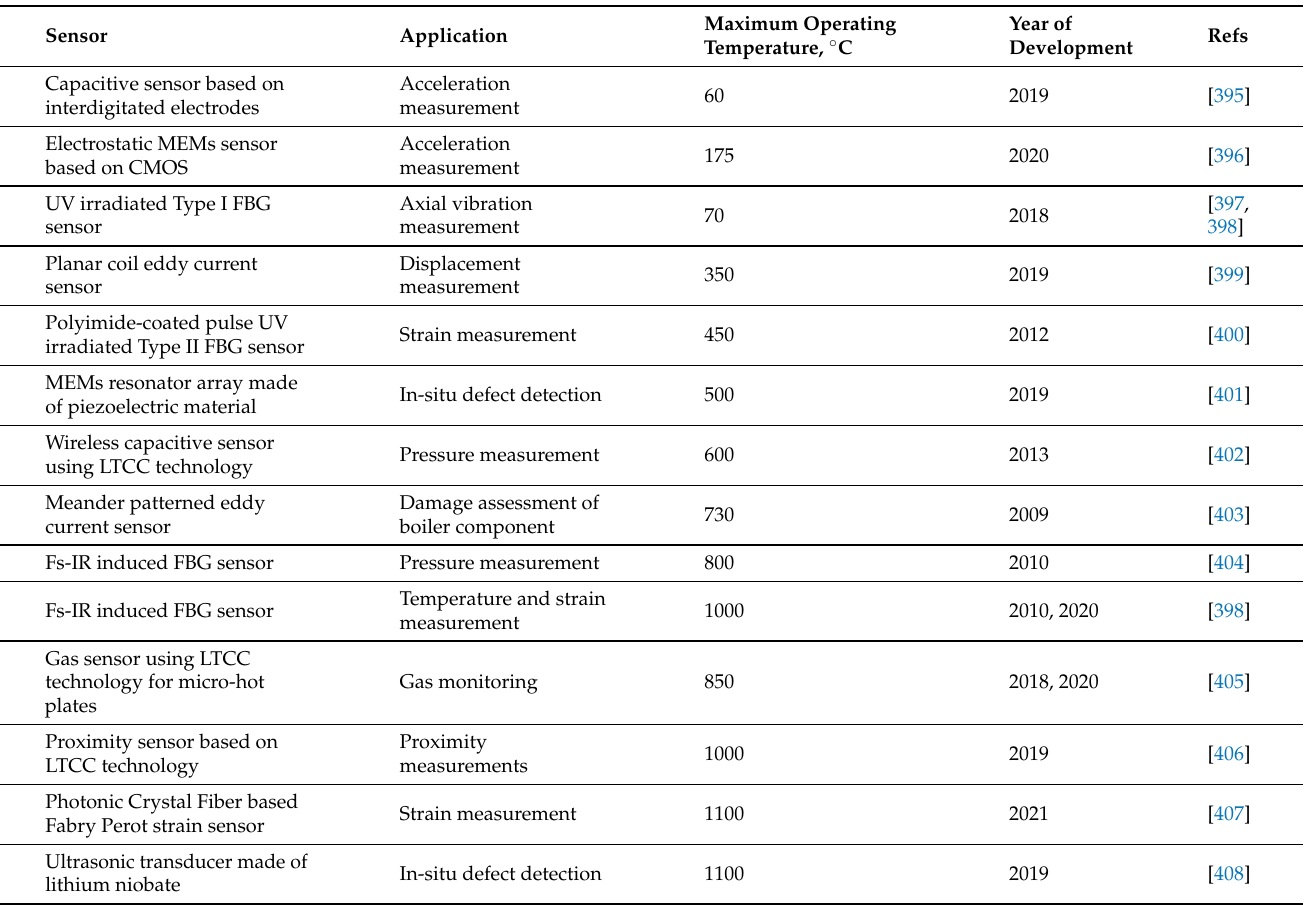
Table 25. Sensor specifications based on maximum operating